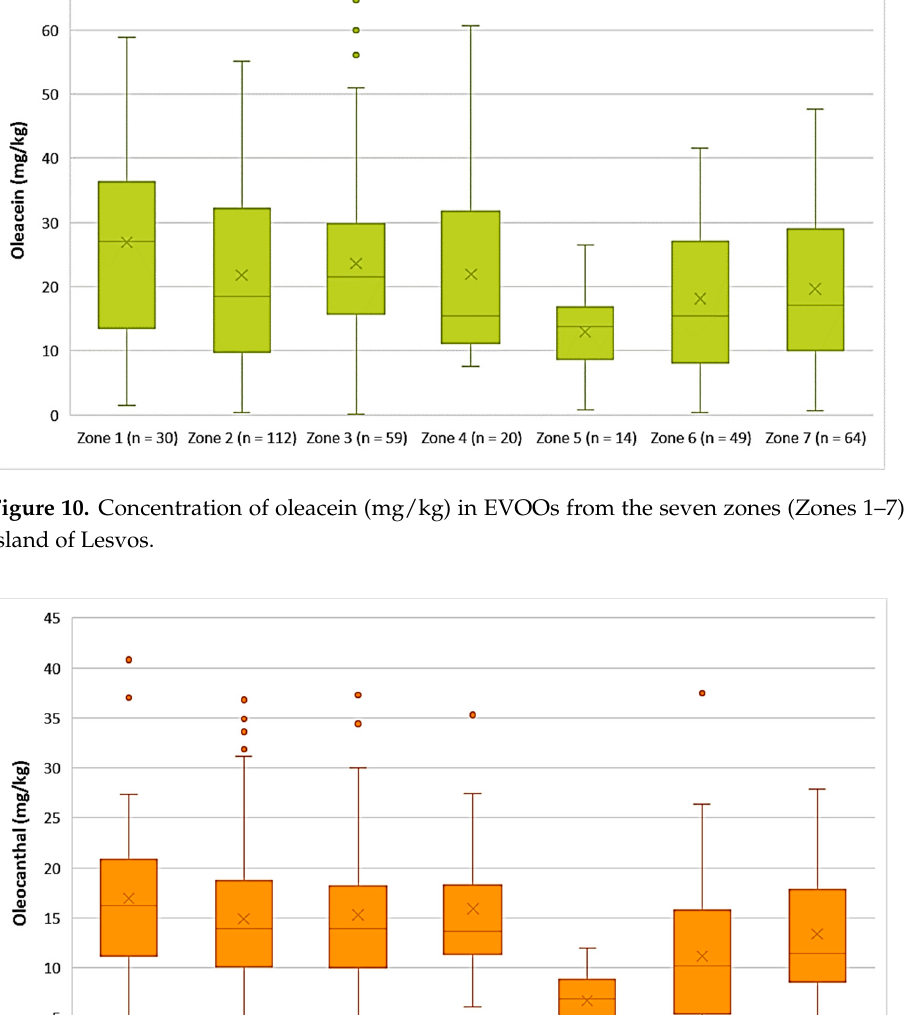
Figure 10. Concentration of oleacein (mg/kg) in EVOOs from the seven zones (Zones 1–7) of the island of Lesvos.